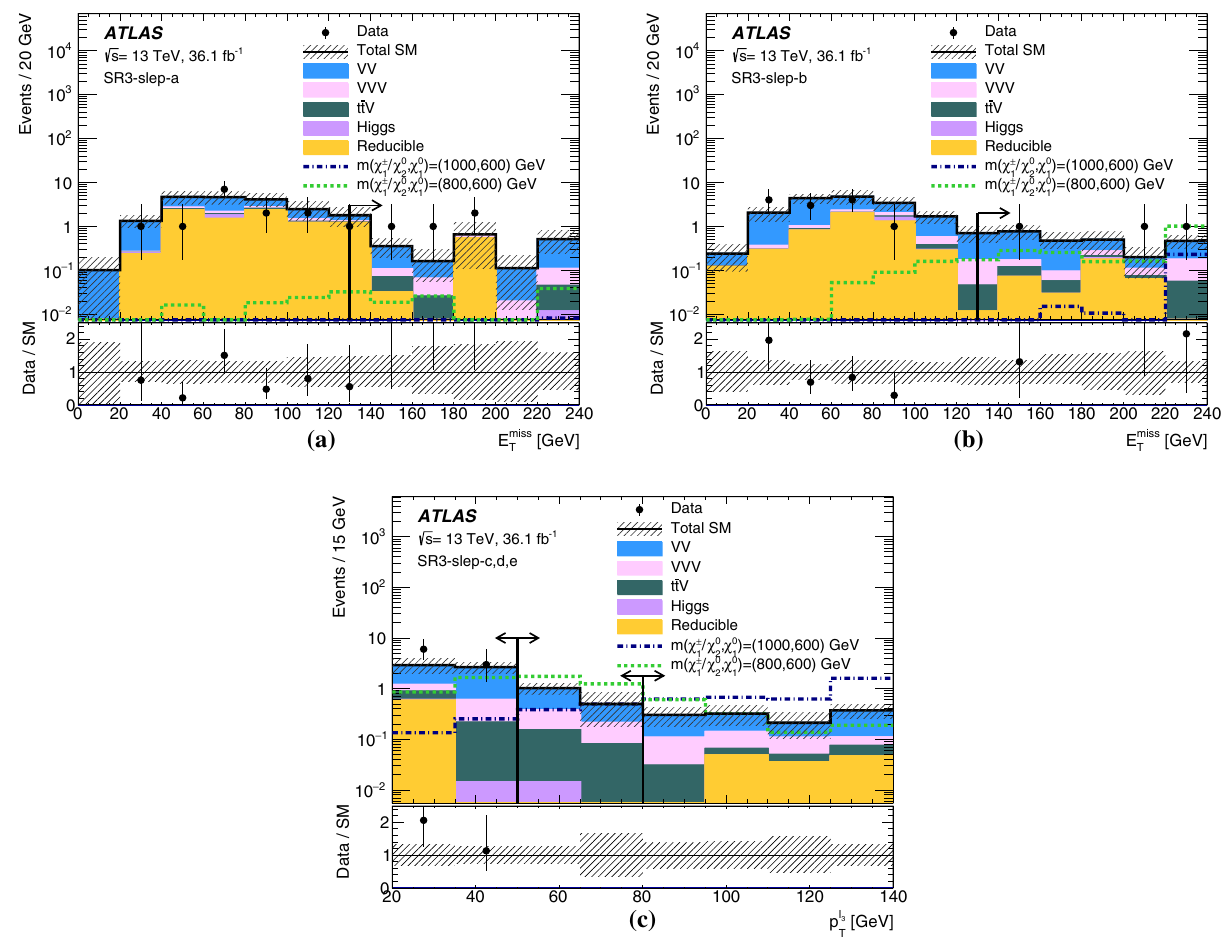
Fig. 6 Distributions of E miss the data-driven fake-factor estimate. The uncertainty bands include all for data and the estimated SM back- T systematic and statistical contributions. Simulated signal models for grounds in the 3 (cid:4) channel for a SR3-slep-a and b SR3-slep-b and c charginos/neutralinos production are overlayed for comparison. The distributions of the third leading lepton p T in SR3-slep-c,d,e. The nor- final bin in each histogram also contains the events in the overflow bin malization factors extracted from the corresponding CRs are used to rescale the W Z background. The “reducible” category corresponds to